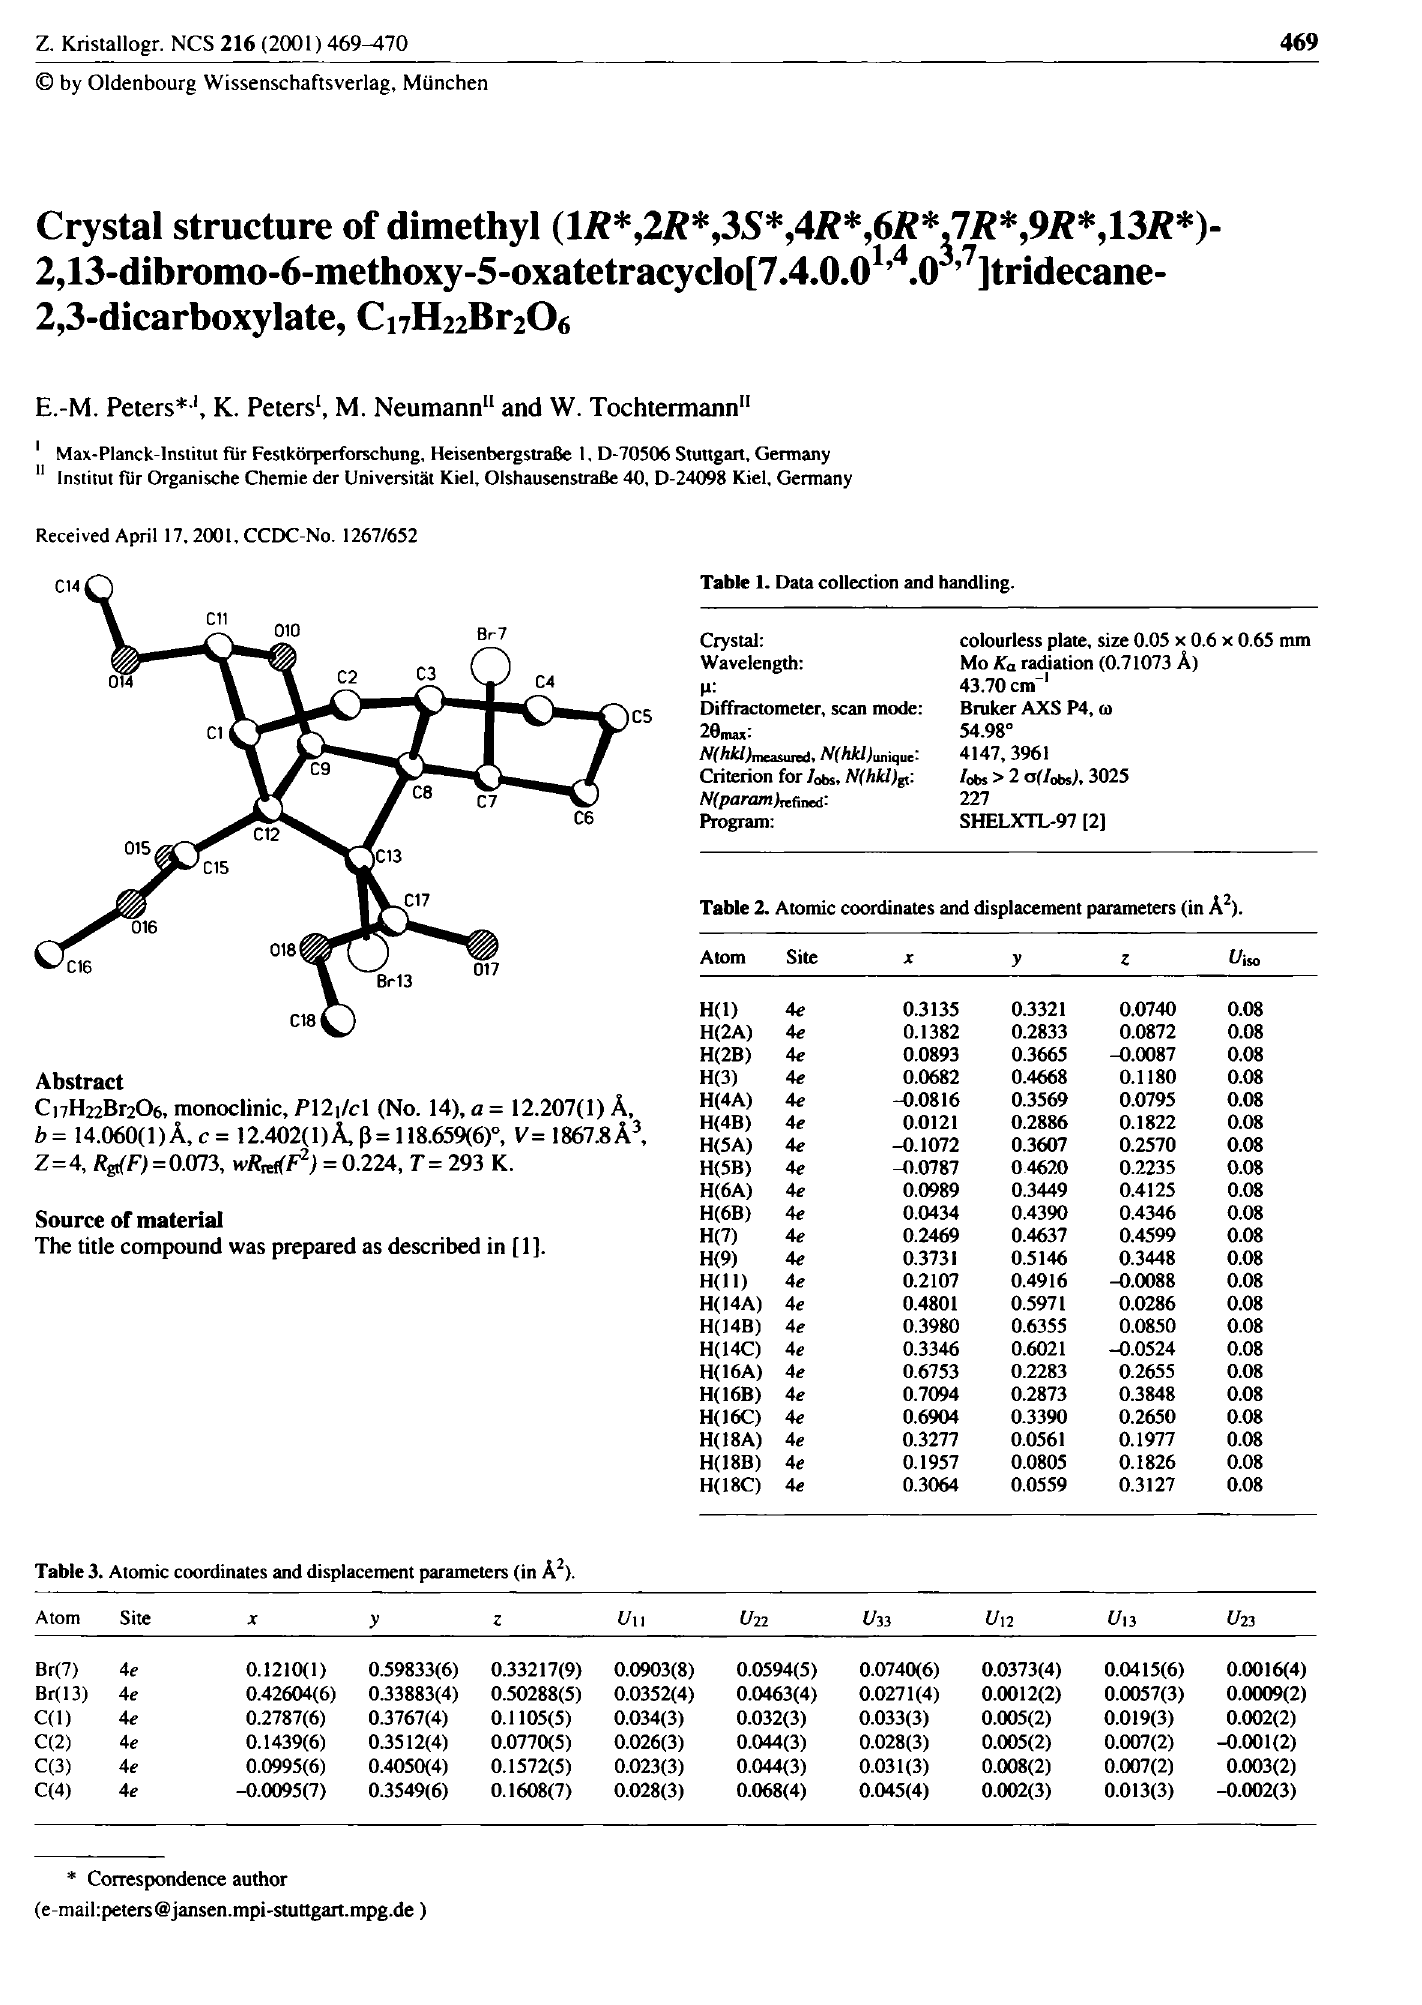
Table 3. Atomic coordinates and displacement parameters (in Ä 2